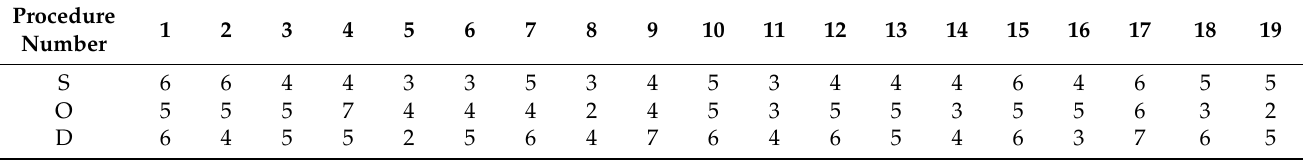
Table A2. Values of risk coefficient correlation calculation parameters.